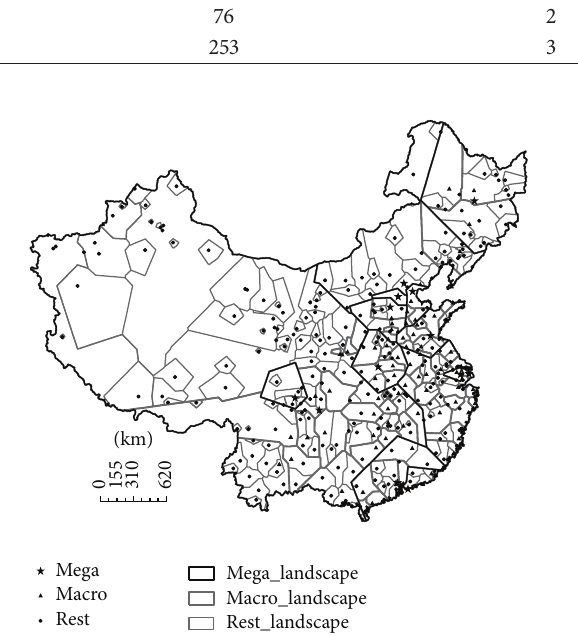
Figure 5: The population landscape pattern of urban hierarchy for China based on the Manhattan